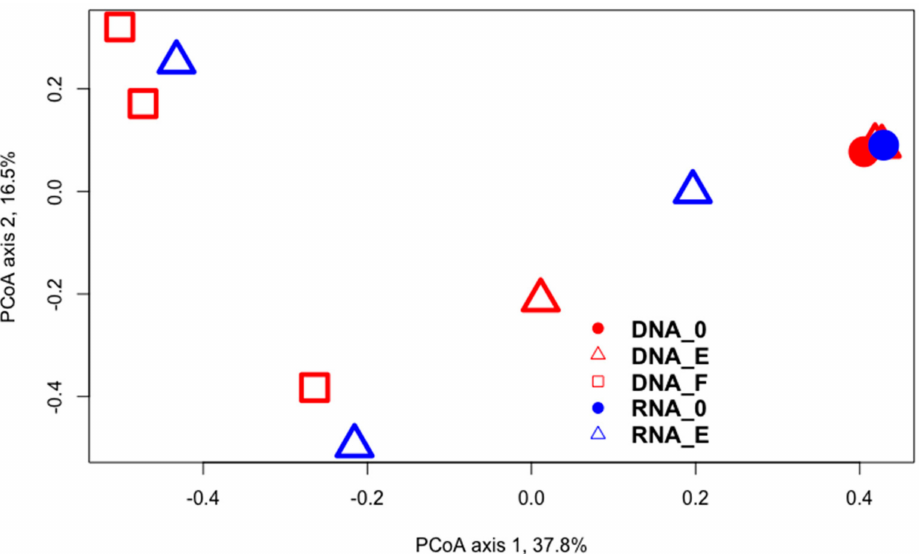
Figure 1. PCoA plot on archaeal samples. Samples DNA_0 and RNA_0 are the samples representing original fracture fluids. Samples DNA_E and RNA_E are enriched microcosm samples and DNA_F represent acetate assimilating labelled fractions. Axis 1 and 2 explain 37.8% and 16.5% of the variance,